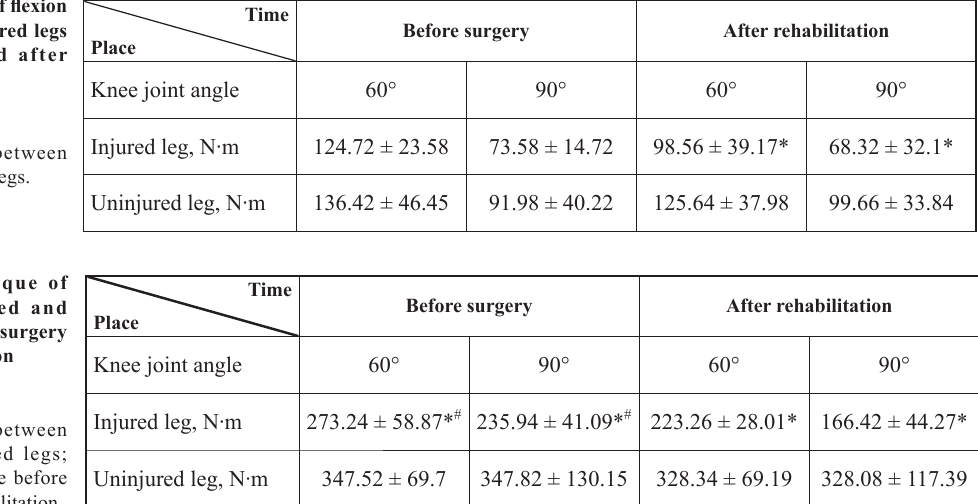
Note. * – p < 0.05 between injured and uninjured legs.